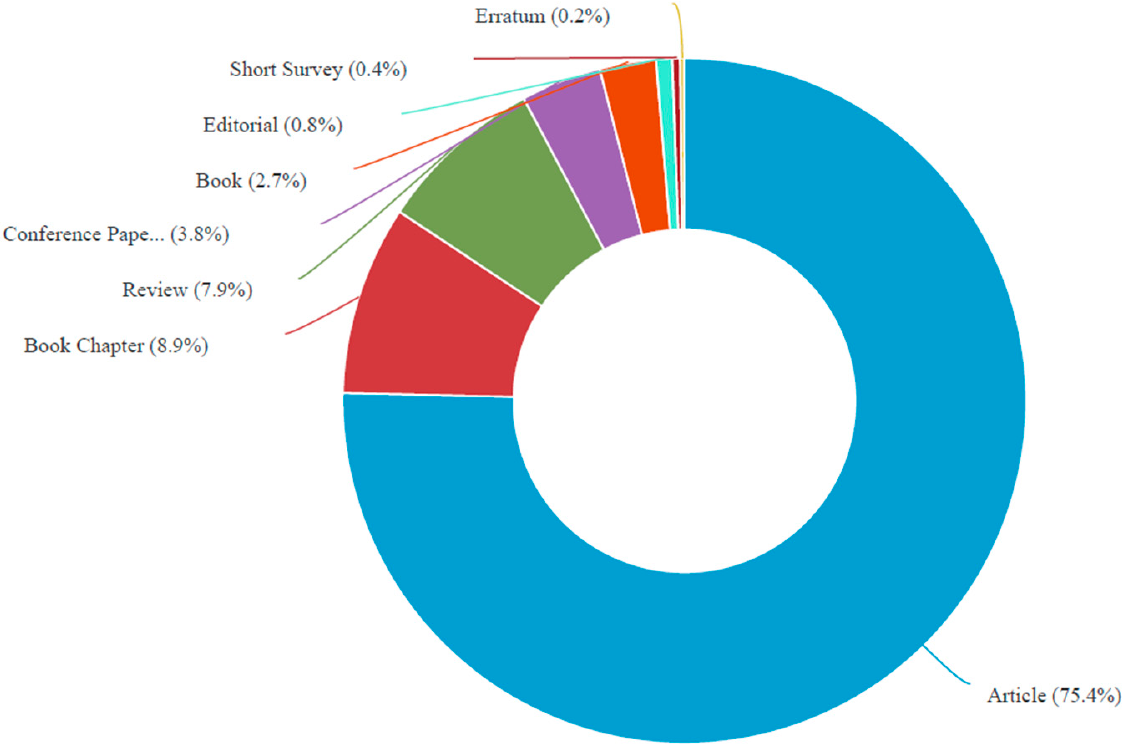
Figure 3. Expatriation documents by type . Source: Data obtained from Scopus (August 2022).